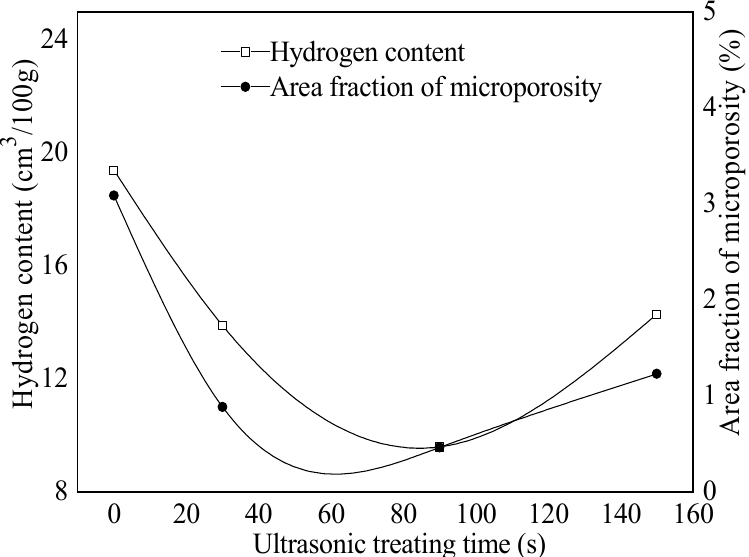
Figure 13. Variation of microporosity and hydrogen content in AZ91 alloy by ultrasonic treating time.